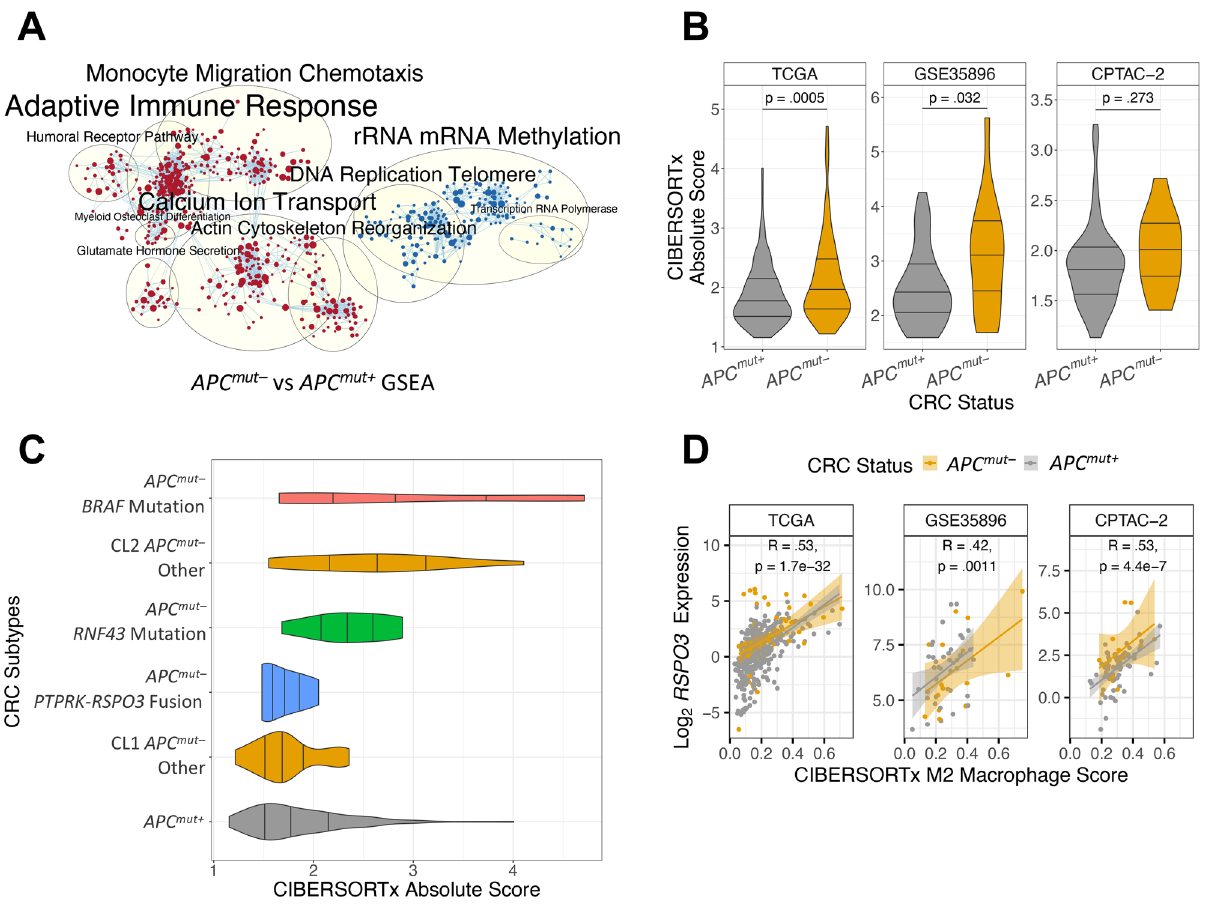
Figure 3. APC mut– CRCs associated with immune infiltration. ( A ) GSEA results of differential gene expression analysis of APC mut– versus APC mut + CRCs from the TCGA dataset. Red clusters represent GO terms enriched among upregulated genes in APC mut– CRCs and blue clusters correspond to down-regulated processes. ( B ) CIBERSORTx absolute score in CRCs from the TCGA, GSE35896 and CPTAC-2 datasets. Two-sample t-tests with a two-tailed p-value were used to test statistical significance. ( C ) Violin plot of CIBERSORTx absolute score across subtypes of APC mut– CRCs. ( D ) Expression of RSPO3 in APC mut– and APC mut + CRCs plotted against their individual M2 macrophage scores identified from the CIBERSORTx algorithm. Pearson correlation was performed to determine statistical